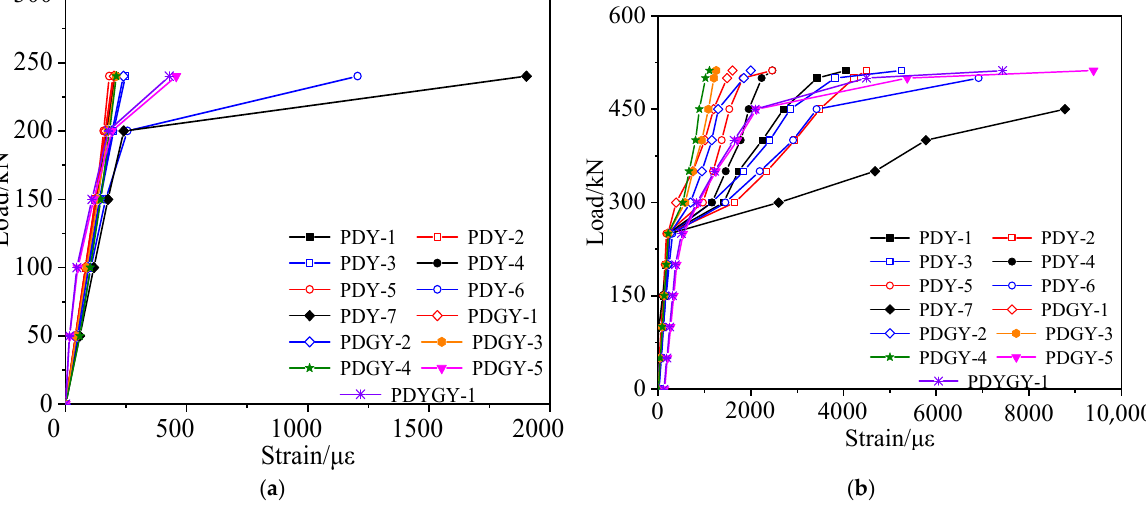
Figure 20. Strain vs. load curve of the damaged test box girder bottom plate. ( a ) Working stage with cracks; ( b ) The failure stage.